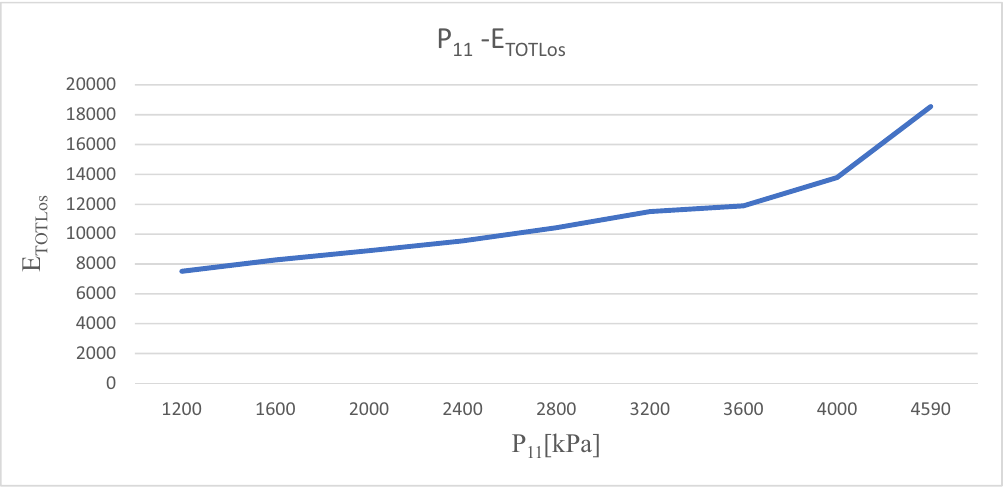
Figure 8: Total compressor losses curve obtained for di ff erent outlet pressures at which the fi rst - stage compressor of the vapor com - pression three - stage cascade cryogenic cycle can operate.